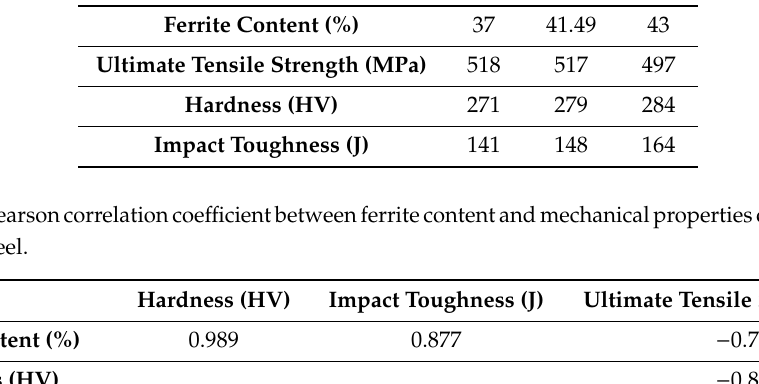
Table 19. Mechanical properties of martensitic stainless steel at di ff erent ferrite compositions [120].